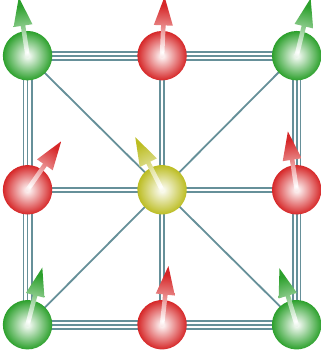
FIG. 12. Graph for the LTFIM lattice model. The different col- ors used for the vertices emphasize the fact that sites that share the same color also share the same parameter in the one-qubit gates, and similarly for the different thicknesses of edges used for the two-qubit